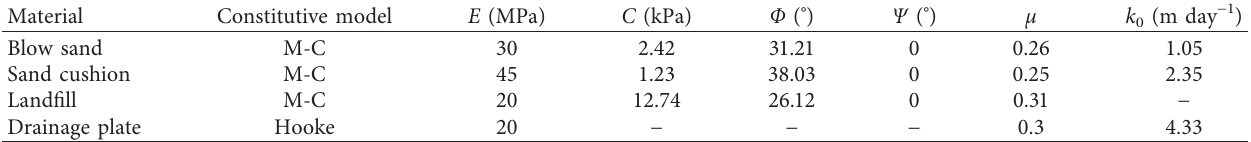
Table 2: Parameters of the material.